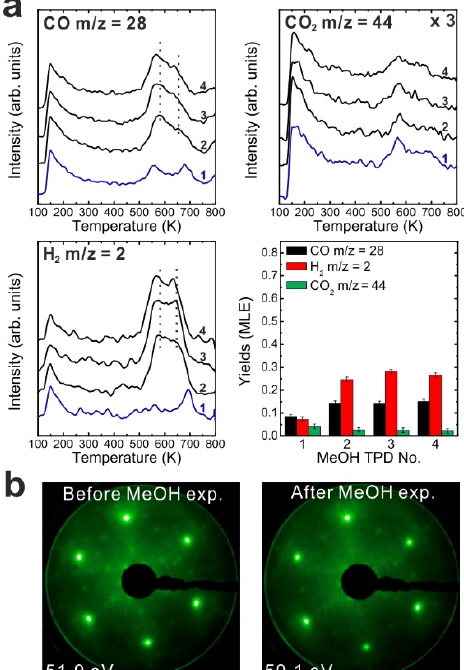
Figure 3. ( a ) Repeated TPD series on a 2.8 ML SmO x film after a treatment of thermal reduction and the estimated yields of products, and ( b ) LEED results before and after the repeated MeOH TPD